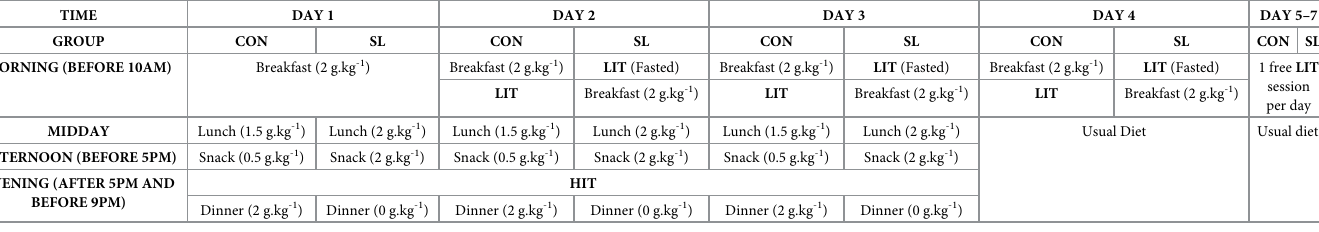
Table 2. Overview of prescribed exercise (in bold) and CHO intake (g � kg -1 � BM -1 ) during 1-week of the intervention for sleep low (SL) and control (CON) groups.